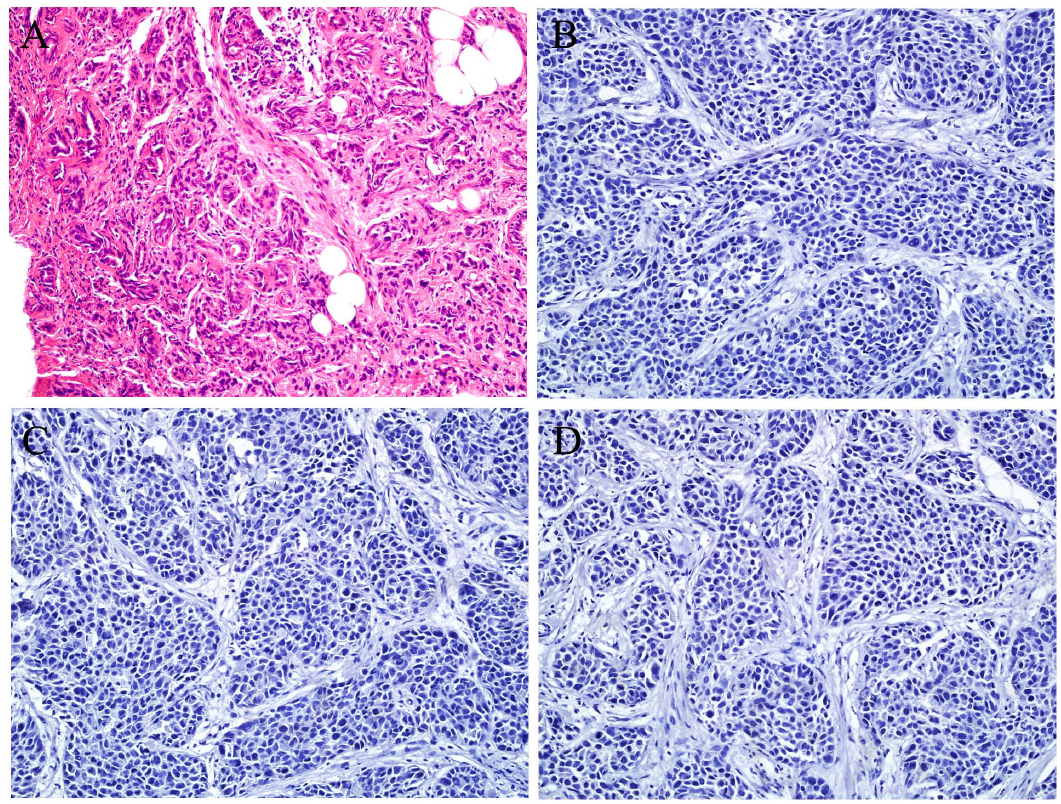
Figure 1. Microphotographs ( 6 200) of a representative TNBC case. A: Hematoxylin-eosin staining. B–D: Immunohistochemical detection for ER, PR and HER-2, respectively. This case is negative for ER, PR and HER-2 (triple negative).